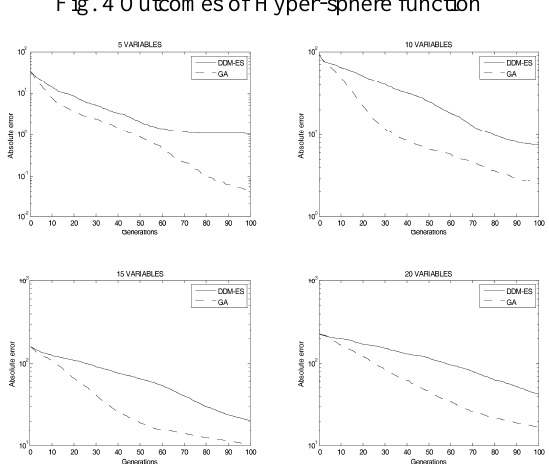
Fig. 5 Outcomes of Rastrigin’s